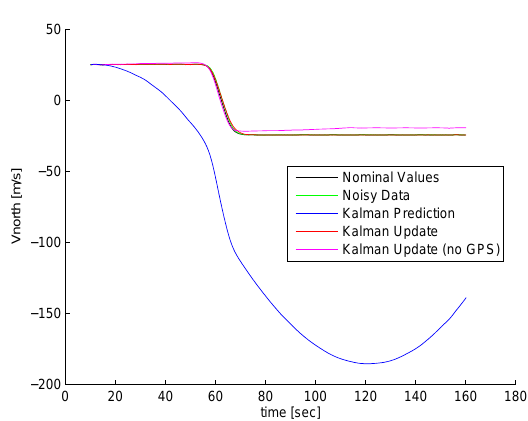
Figure 10: Linear speed in North direction (Roma Sequence). Nominal value (black line), Kalman Prediction without GPS (blue line), Kalman Update (red line), Kalman Update without GPS (magenta